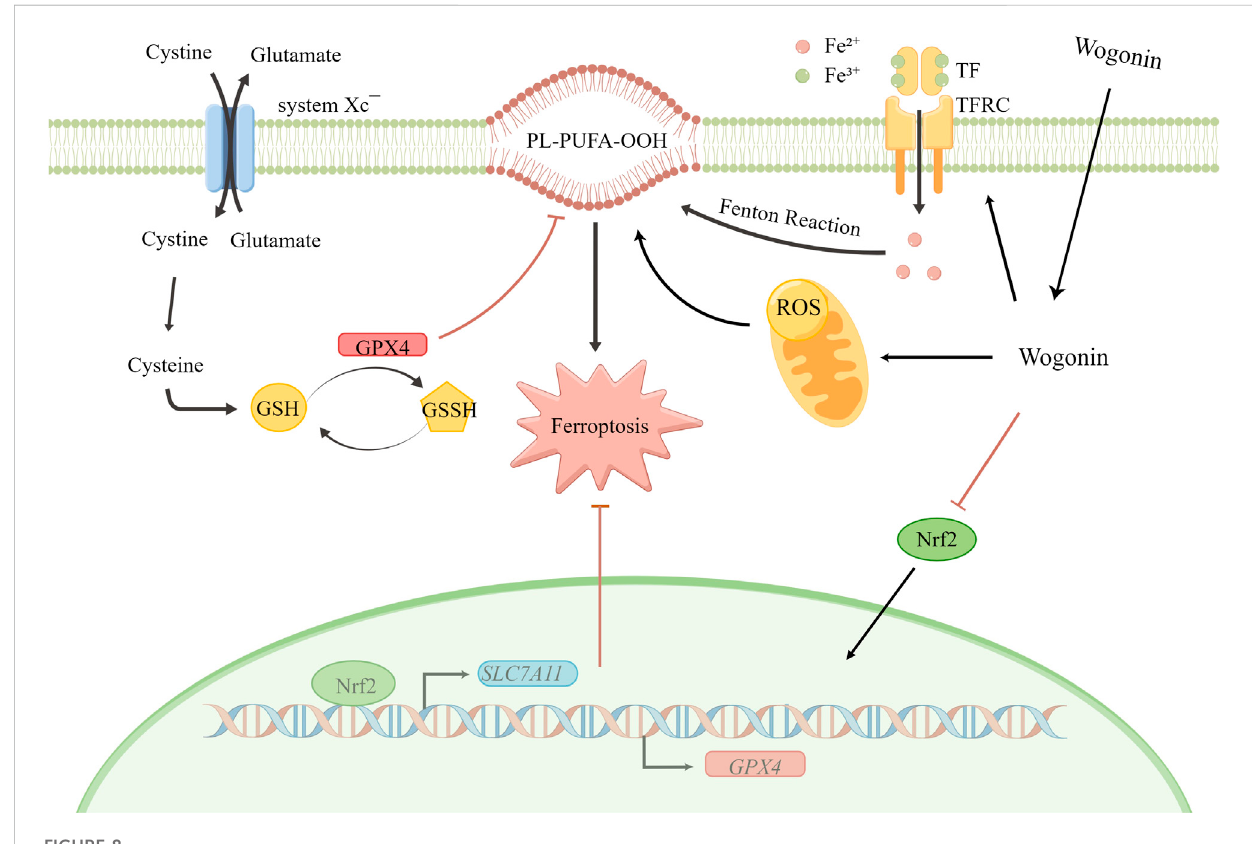
FIGURE 8 Schematic diagram for wogonin-induced ferroptosis in pancreatic cancer